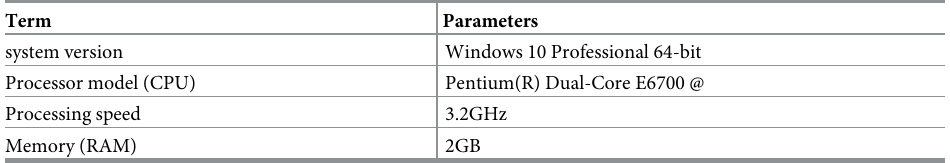
Table 2. Test platform